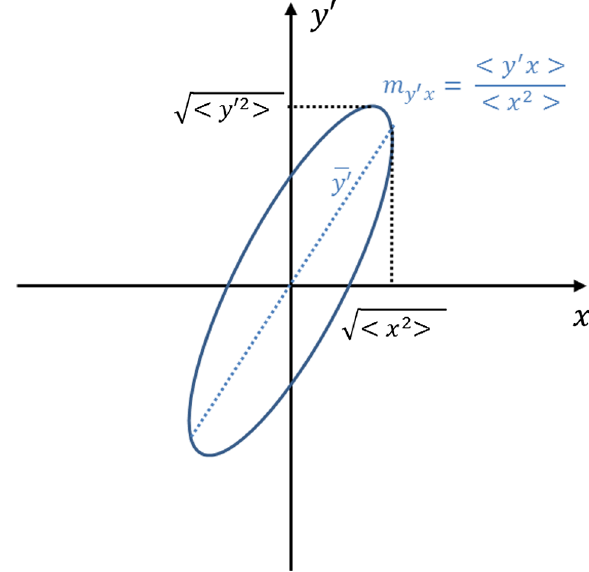
FIG. 2. Magnetic flux through the beam rms-area field components do not contribute to the flux as they are perpendicular to the normal of the area.